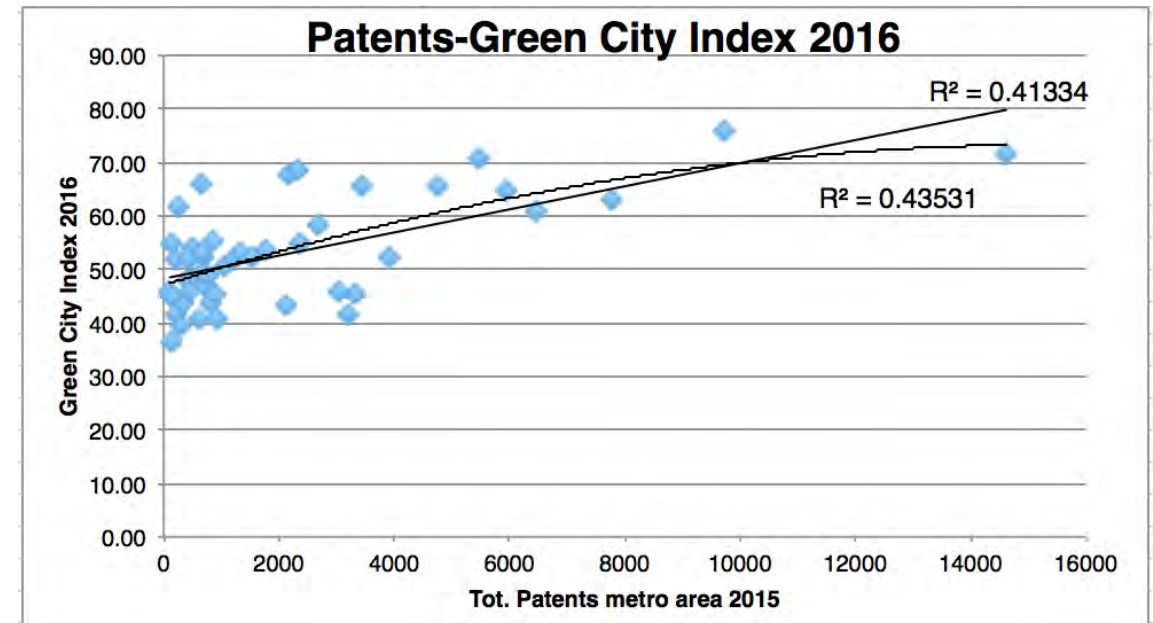
Figure 7. Regression between Patents and Green City Index for US metro